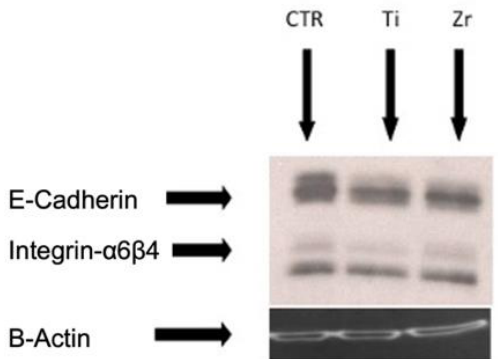
Figure 7. Western blot showing E-cadherin and Integrin- α 6 β 4 expression from cell lysate of keratinocyte cultures. The adhesion molecules were expressed in a similar manner in C, T1, and T2.